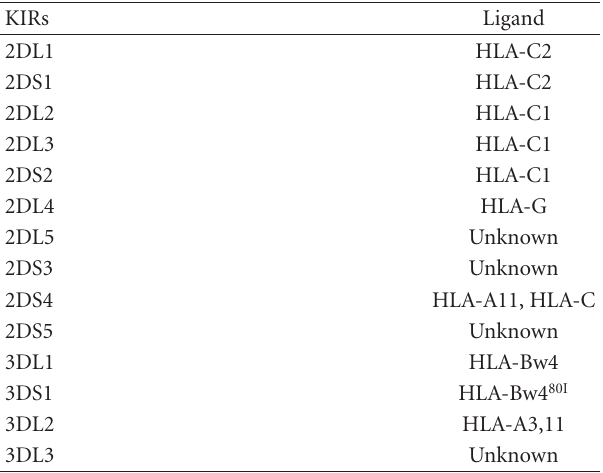
Table 1: KIRs molecules and their HLA